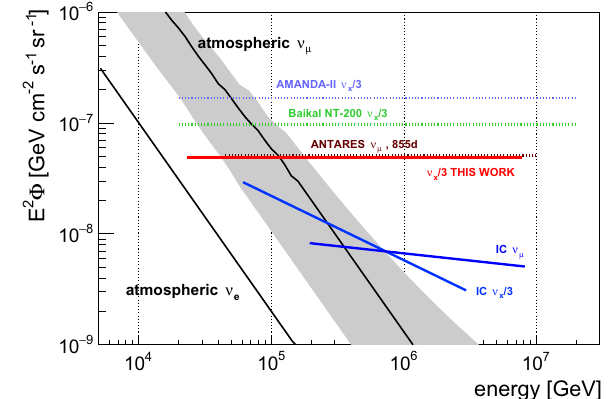
Fig. 4 Distributionofthereconstructedshowerenergyfor1247daysof data taking, selected as described in Sect. 4 and with a cut on the recon- structed zenith angle applied at (cid:7) rec ≥ 94 ◦ ( black markers , statistical errors only). Simulated contributions from atmospheric muons ( blue ), atmospheric neutrinos ( red ) and an astrophysical flux [6] ( green ) have beenoverlaidforcomparison. Colouredbands indicatetheuncertainties on the simulated and measured flux normalisations. The atmospheric muon contribution beyond 10TeV has been extrapolated as described in Sect. 6